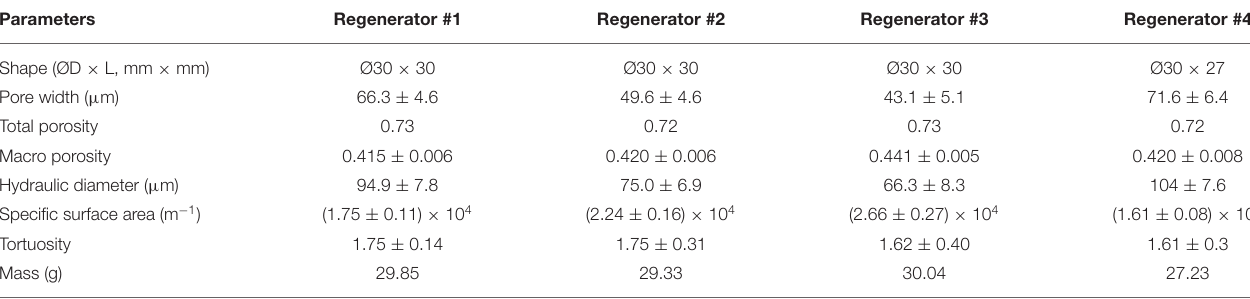
TABLE 1 | Geometrical parameters of the freeze-cast regenerators.